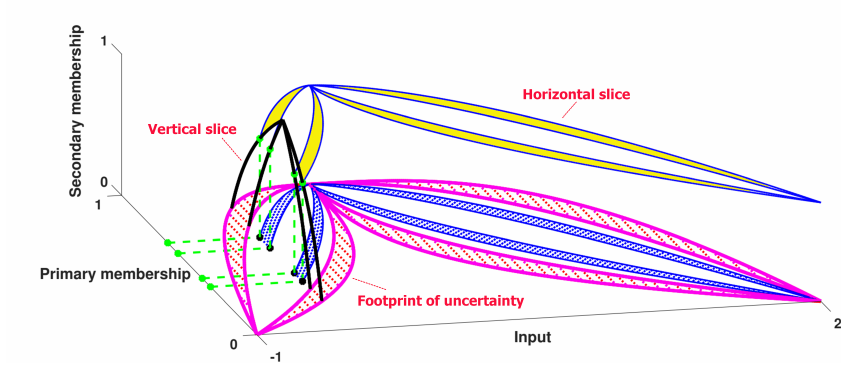
Figure 3. The type-3